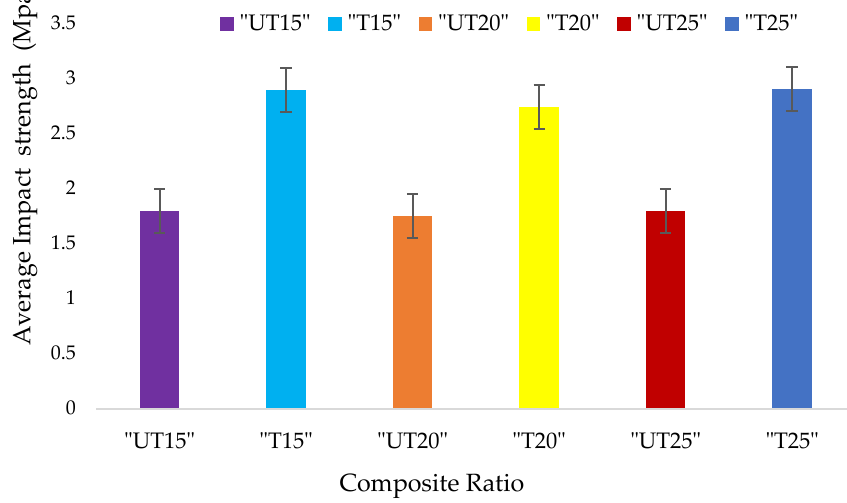
Figure 5. Impact strength test results of CH composite.